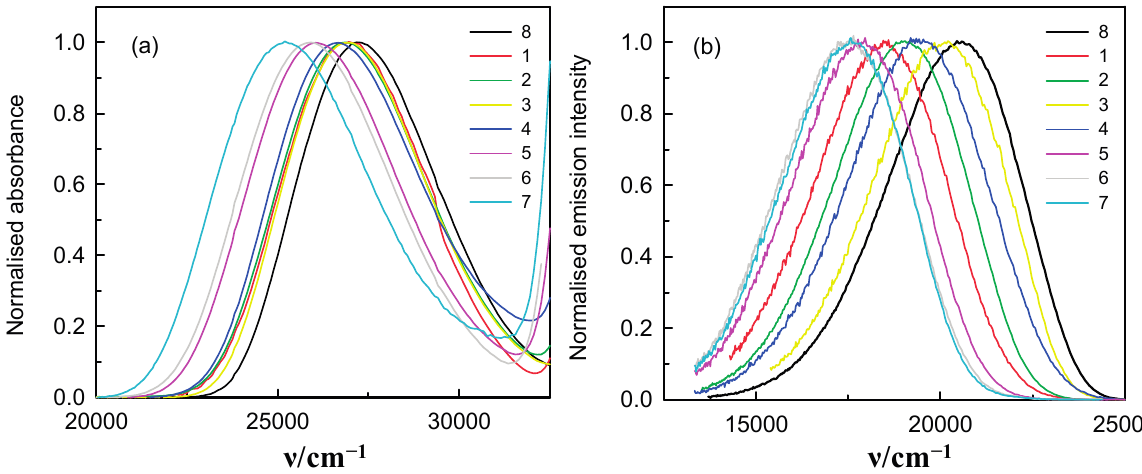
Figure 2. Normalised absorption ( a ) and fluorescence ( b ) spectra of 6AC in (1) acrylonitrile; (2) b propionitrile; (3) di- n -butyl ether (DBE); (4) tetrahydrofuran (THF); (5) N , N -dimethylformamide (DMF); (6) a dimethyl sulphoxide (DMSO); (7) hexamethylphosphoramide (HMPA); and (8) a , b 1-chloro- n -propane. a From reference